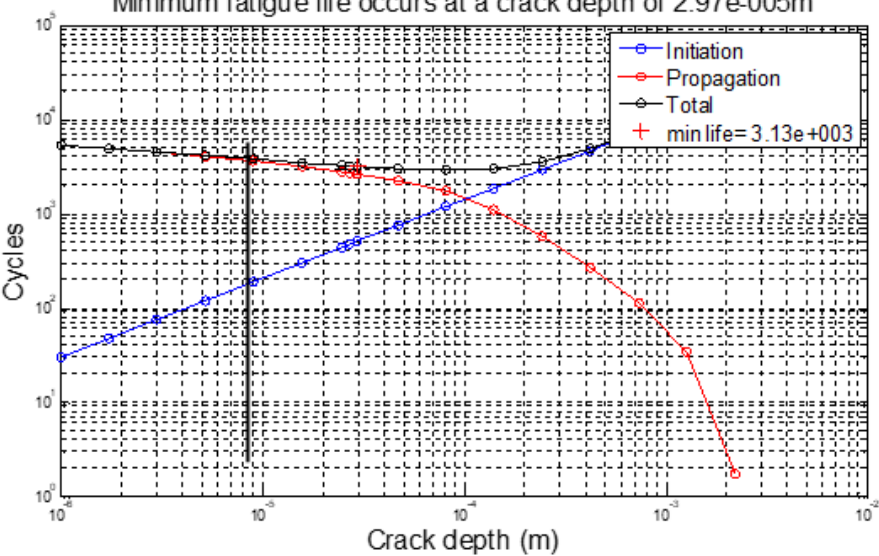
Figure 8. Total fatigue life shows a minimum at a crack depth of a i ≈ 30 µ m at a stress range of 800 MPa.